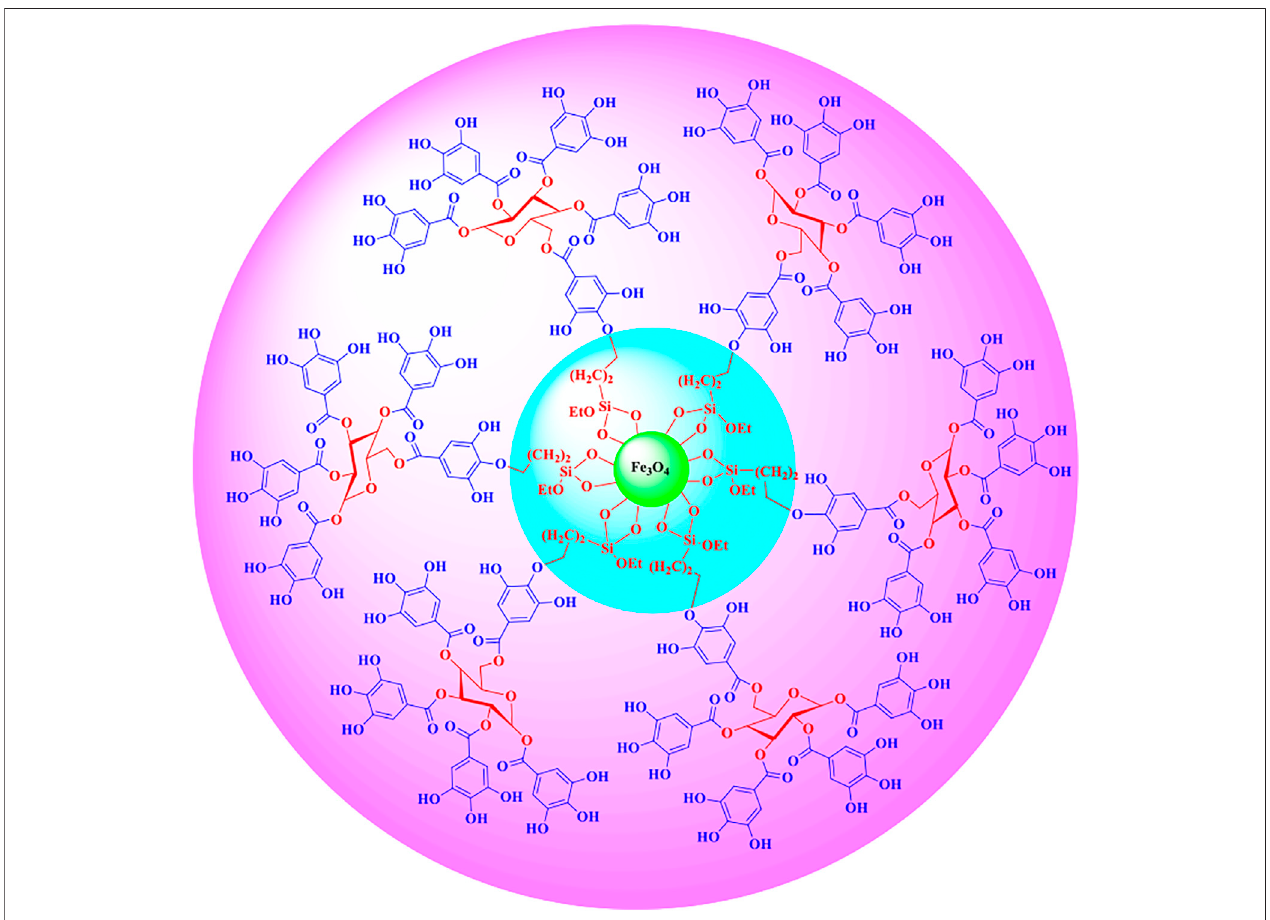
FIGURE 2 | Structure of Fe 3 O 4 @SiO 2 @Tannic acid